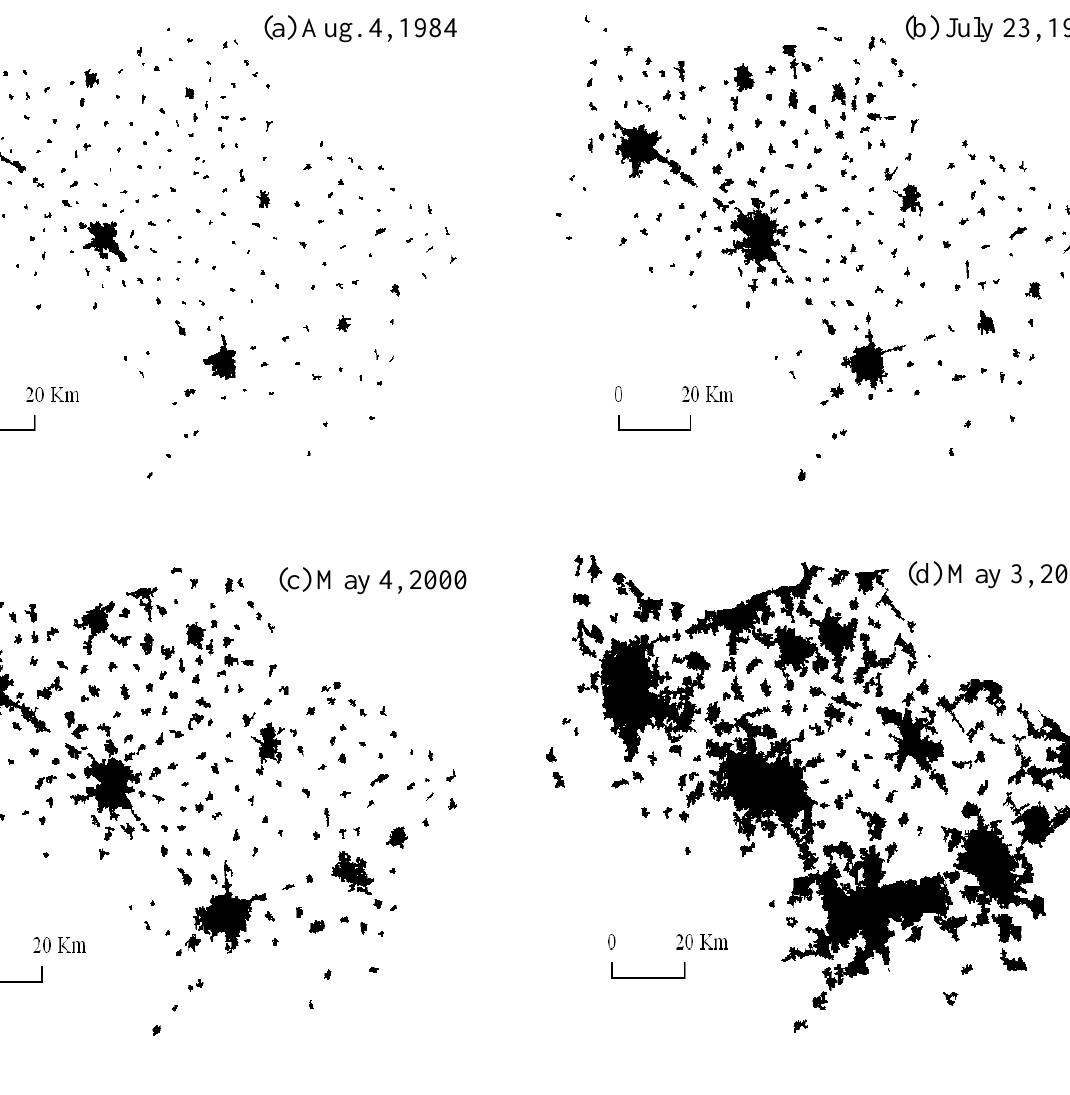
Figure 2. The urban morphology of Sunan in different